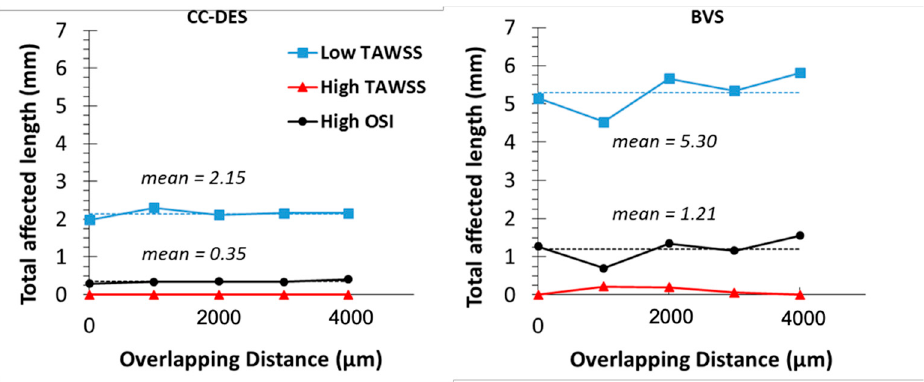
Figure 14. Evolution of affected arterial length vs. overlapping distance (OD).